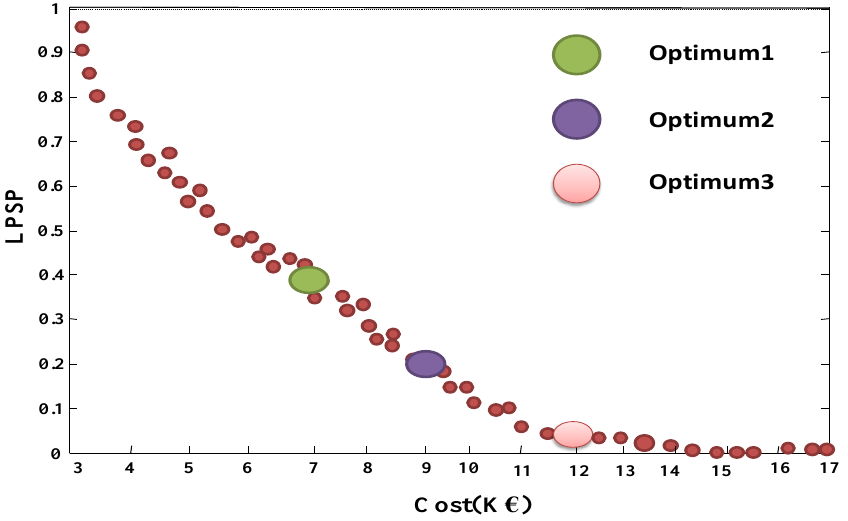
Figure 17. Particulate configurations from the good compromise zone of the optimal front.